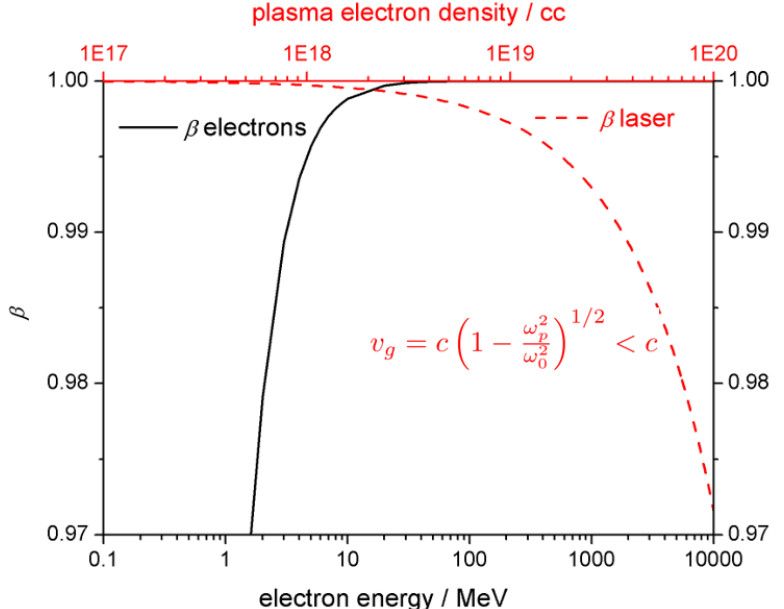
Figure 5. The velocity of electrons in plasma is independent of plasma density, while the laser pulse group velocity in plasma decreases with increasing plasma density. Electron velocities in terms of corresponding β are plotted in black vs. electron energy, while the laser pulse group velocity is plotted in red vs. plasma